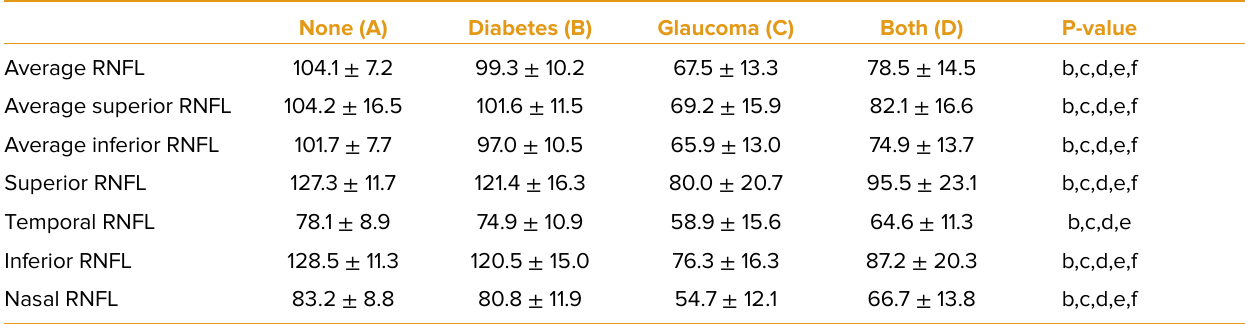
Table 2. Table showing the retinal nerve fibre layer (RNFL) values in patients with diabetes, glaucoma, both, and none (43 eyes